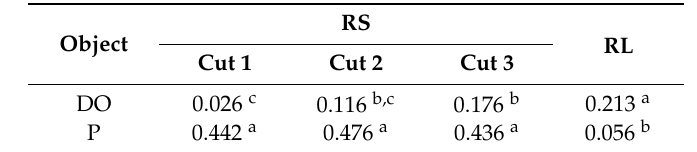
Table 4. Elymus elongatus resistance index (RS) and adaptation (RL) index to contamination with diesel oil (DO) and unleaded petroleum